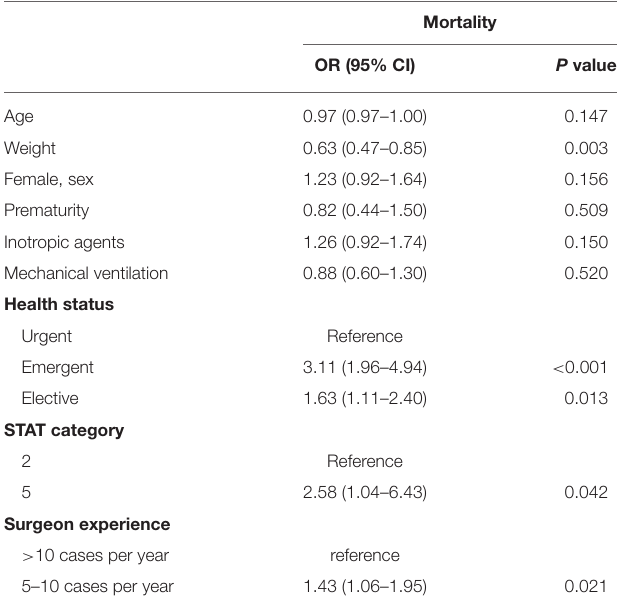
TABLE 3 | Multivariable model of preoperative factors associated with in-hospital